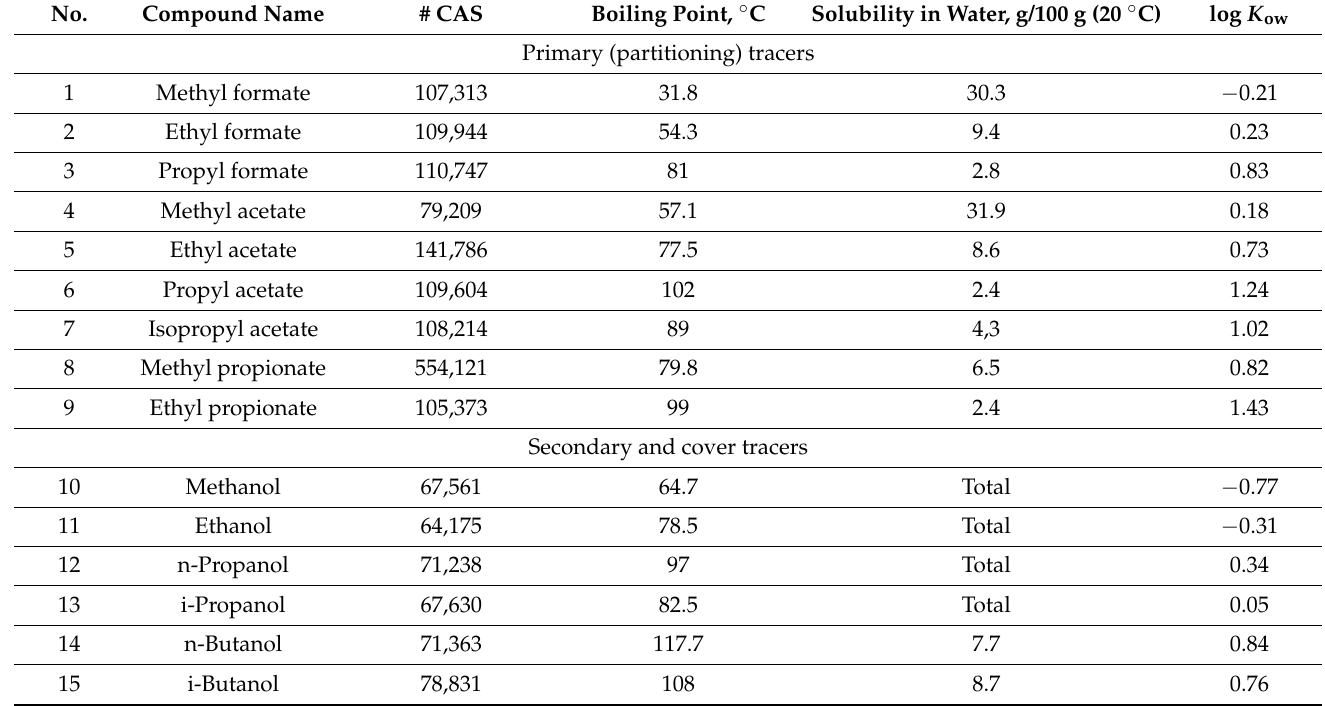
Table 1. Physico-chemical properties of tracer candidates